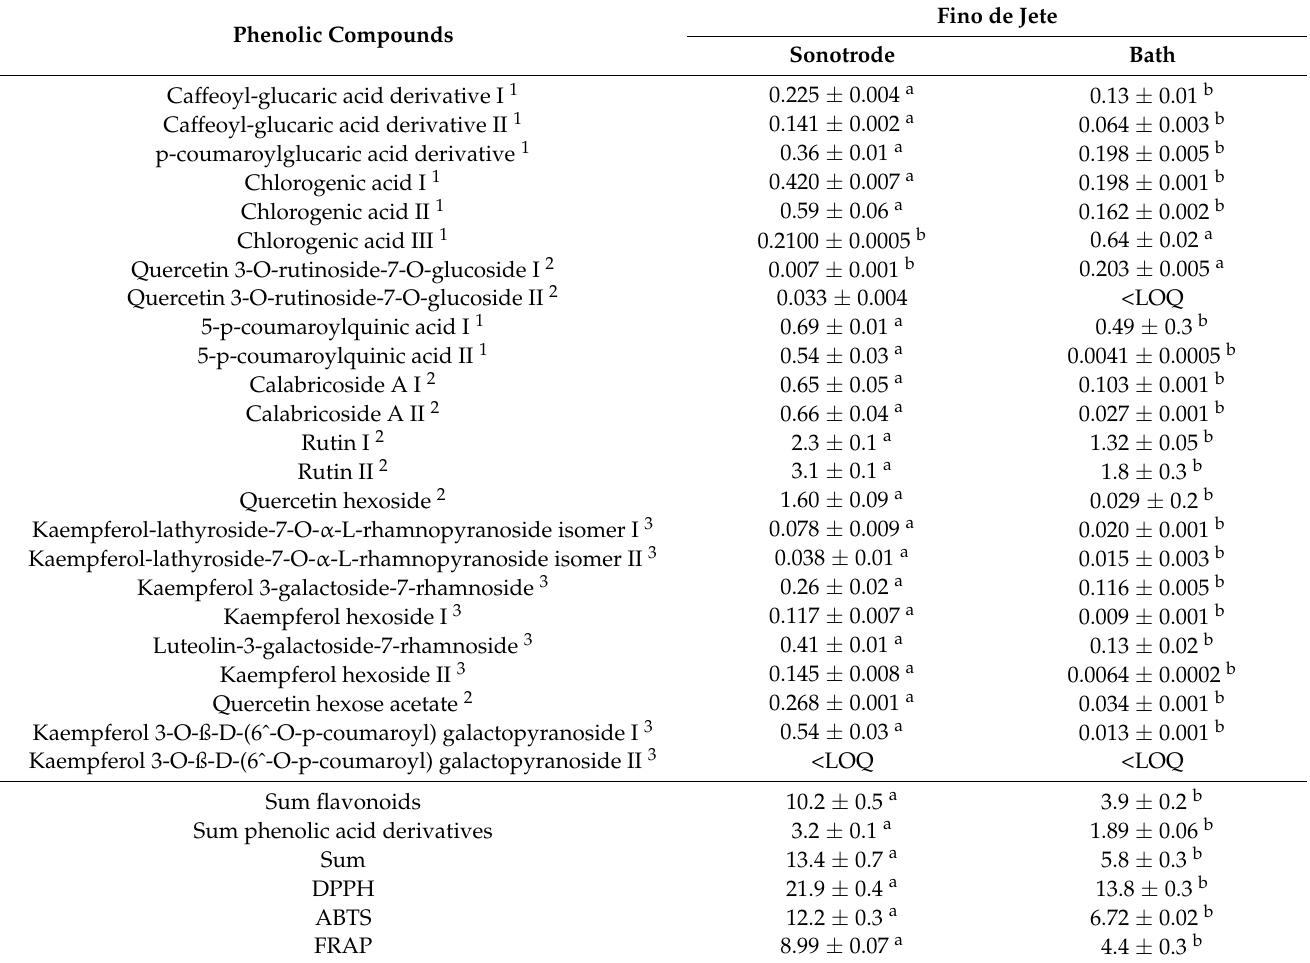
Table 5. Concentration of phenolic compounds (mg/g d.w.) obtained at optimum sonotrode condi- tions and with ultrasonic bath in the ‘Fino de Jete’ cherimoya leaves by